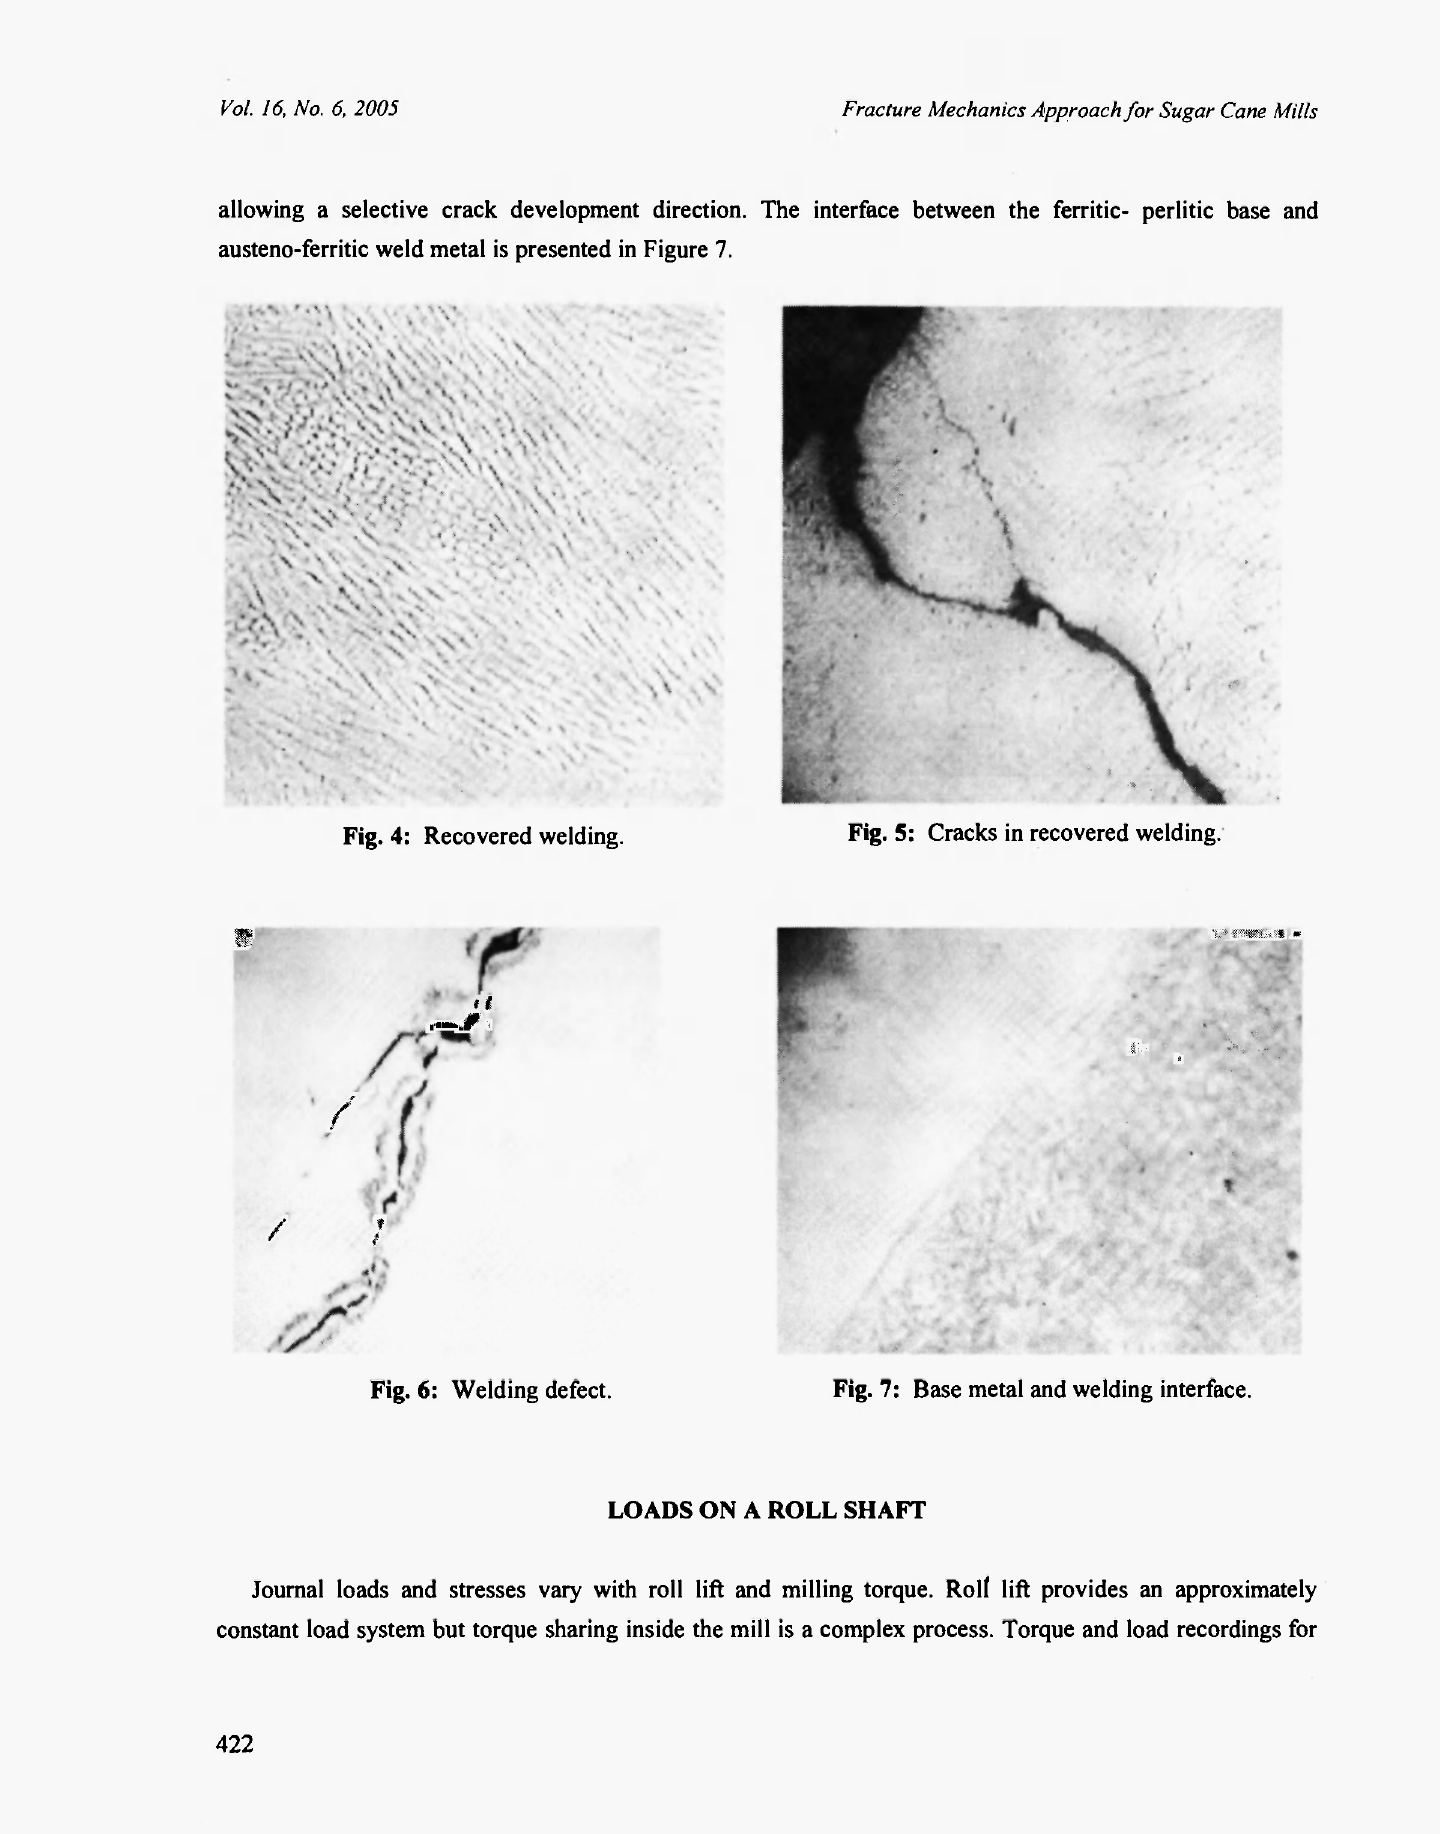
Fig. 4: Recovered welding. Fig. 5: Cracks in recovered welding.